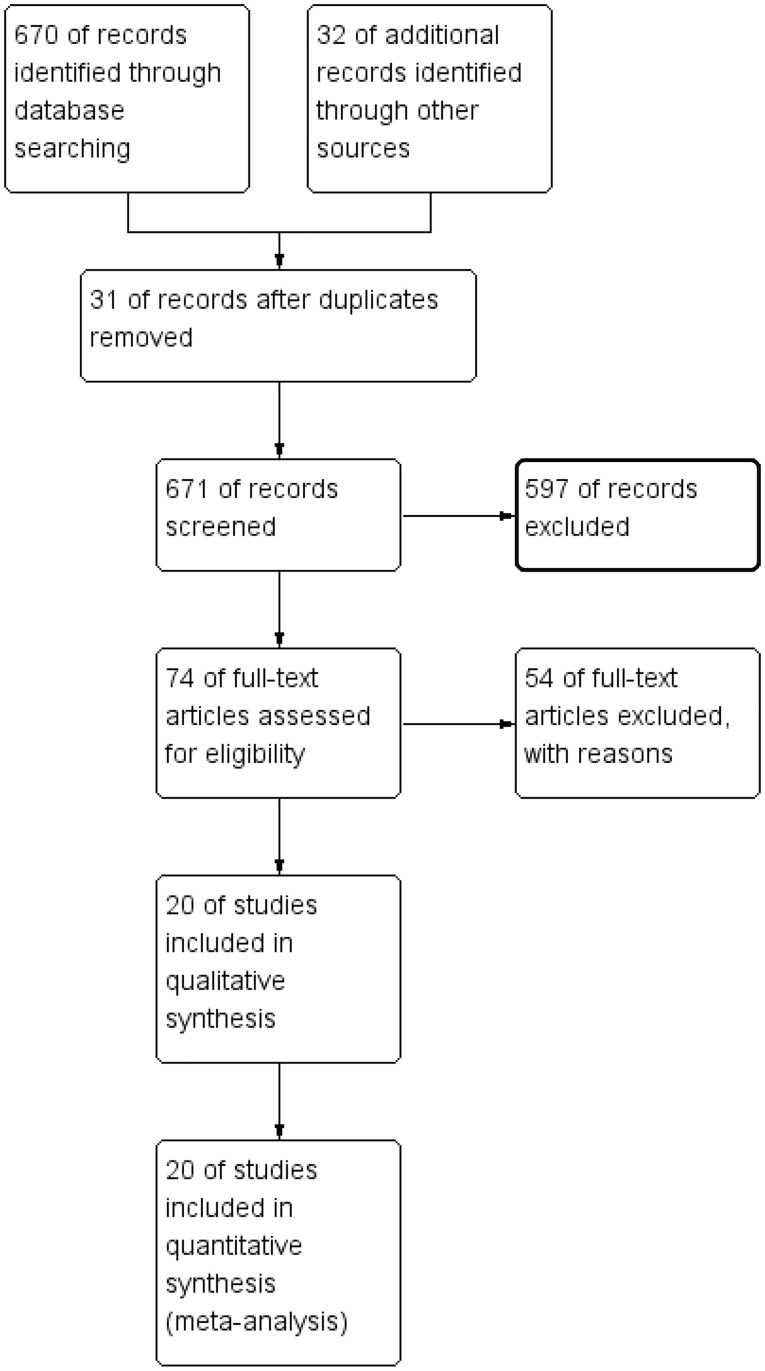
Schematic of the study selection.